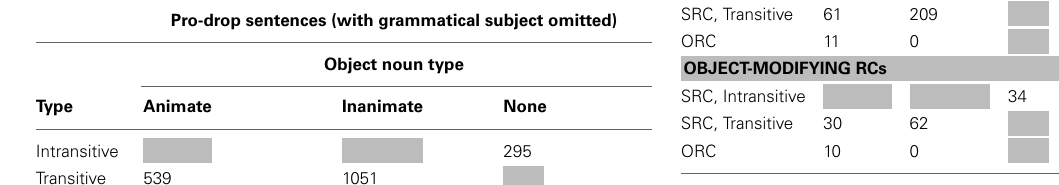
Relative Clause Nouns are the Relative clause object in SRC Transitive sentences and the Relative clause subject in ORC sentences. Gray cells reflect non-existent sentence types (because transitive verbs must have a relative clause noun and intransitive verbs do not have a direct object